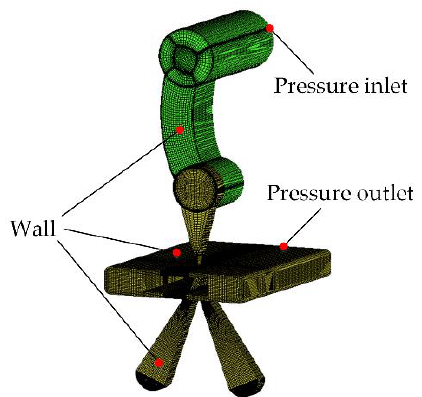
Figure 10. Numerical model of the hydraulic amplifier.